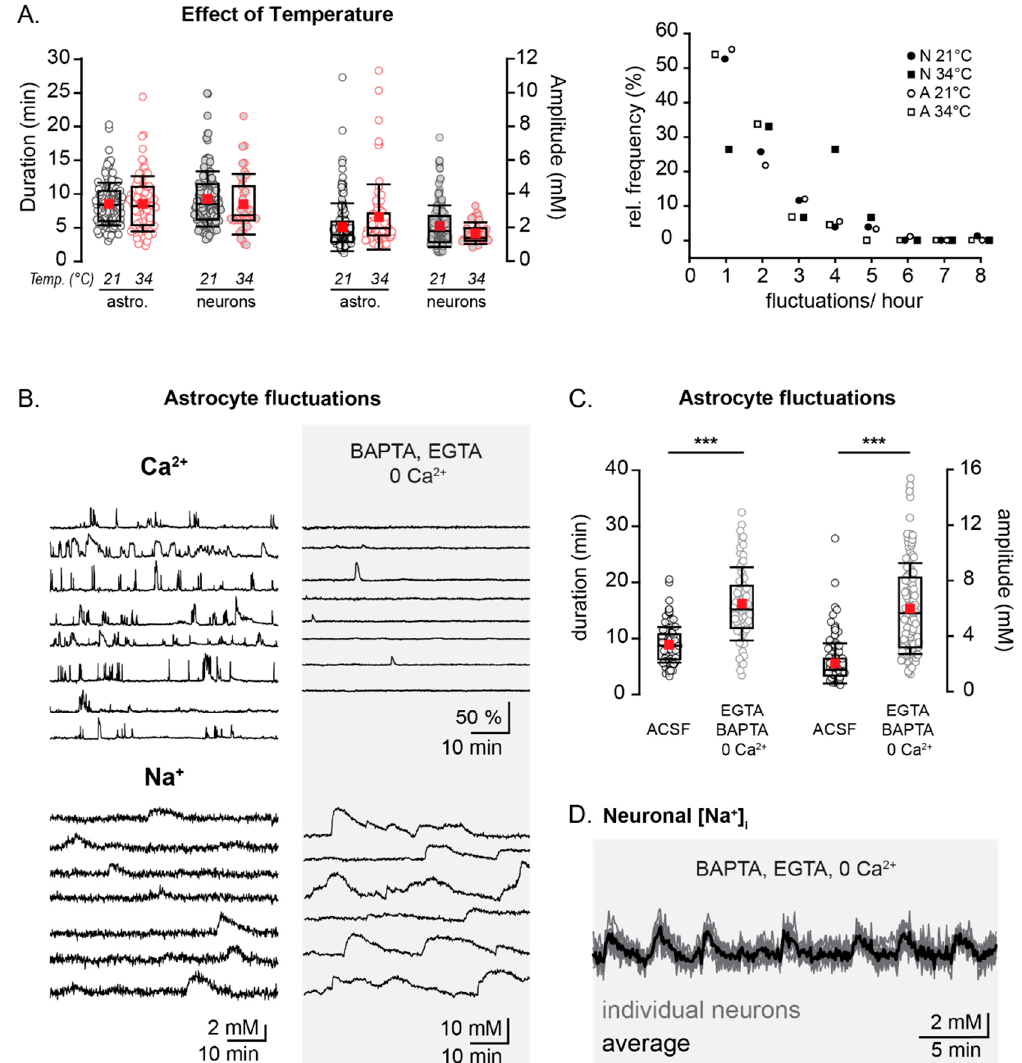
Figure 4. Temperature dependence and interrelation with spontaneous Ca 2+ -signaling. ( A ) Left: duration and amplitude of neonatal astrocytic and neuronal Na + fluctuations at 21 °C (black) and 34 °C (red). Right: Relative frequency distribution plot of neonatal Na + fluctuations at 21 °C (neurons- black circles, astrocytes- white circles) and 34 °C (neurons- black squares, astrocytes- white squares). ( B ) Example traces from individual astrocytes in Ca 2+ imaging experiments (top) and during Na + imaging (bottom), both in ACSF (left) and in the presence of a Ca 2+ chelated solution (0 Ca 2+ , ACSF containing 500 µM BAPTA-AM and 1 mM EGTA) (right). ( C ) Box plots illustrating the increase in astrocytic Na + fluctuation amplitudes after the chelation of Ca 2+ . ( D ) Traces showing Na + fluctuations in several individual neurons (grey) and an averaged trace (black) in a Ca 2+ chelated solution. *** p < 0.001.